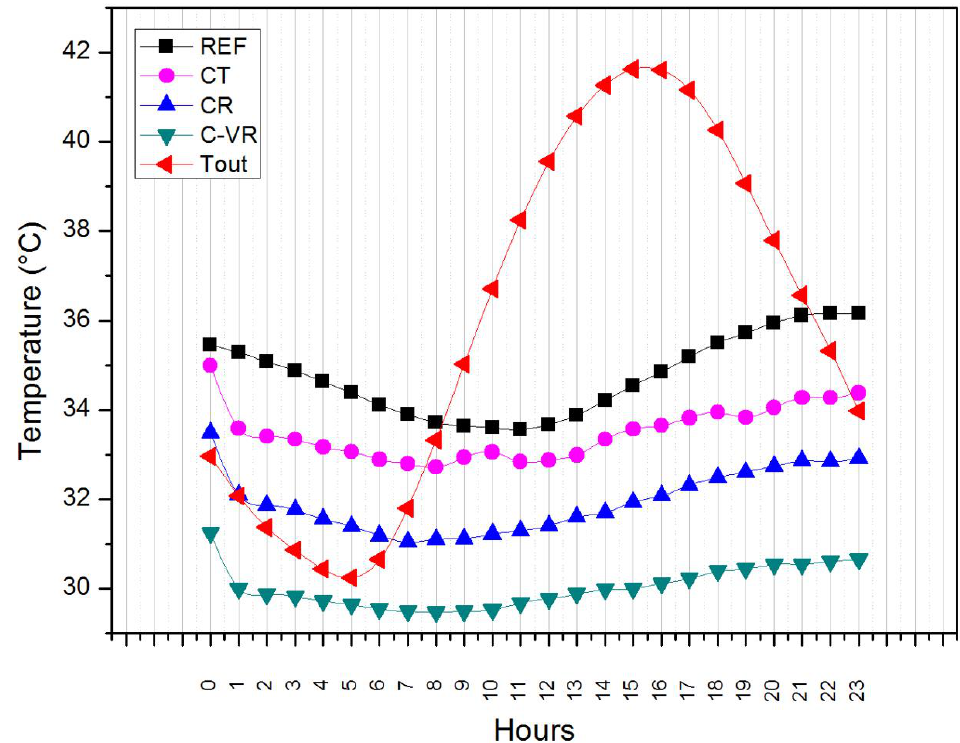
Figure 11. Average indoor air temperature calculated for all passive cooling techniques compared to the reference case during July.